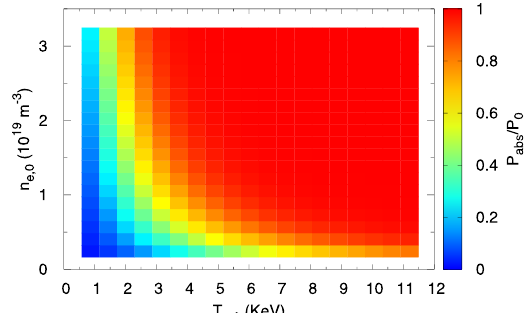
Fig. 4b. Absorbed efficiency as a function of T e,0 , n e,0 (USM).